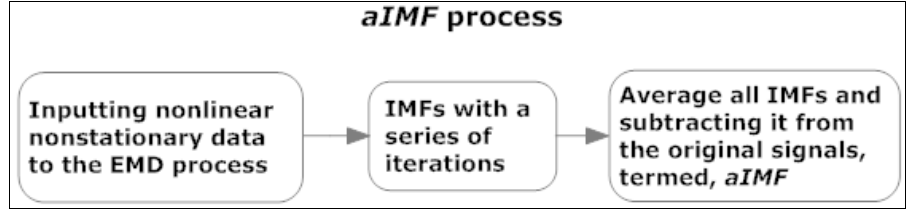
Figure 2. Block diagram of the proposed averaging Intrinsic Mode Function (aIMF)